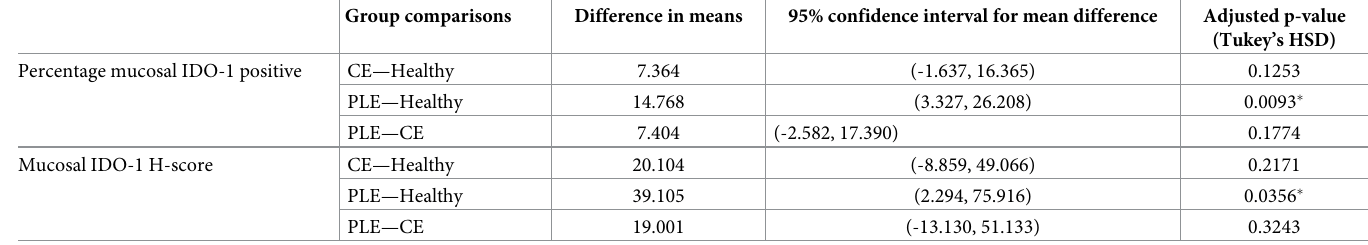
Table 1. Post hoc analysis of IDO-1 mRNA expression in the duodenal mucosa of dogs with protein-losing enteropathy (PLE), chronic enteropathy (CE), and healthy Beagle control dogs using RNA in situ hybridization. P-values obtained from Tukey’s HSD (Honestly Significant Difference) post-hoc analysis after one-way analysis of variance testing of percentage mucosal IDO-1 positive mRNA and IDO-1 H-score in the duodenal mucosa of dogs with PLE (n = 6), dogs with CE (n = 18) and healthy Beagle control dogs (n = 8).